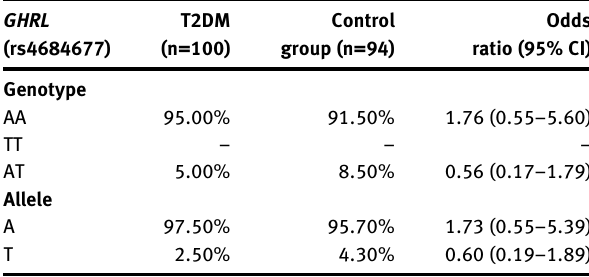
Table  : Distribution of GHRL (rs  ) genotypes and alleles in type  diabetes mellitus patient and control groups.